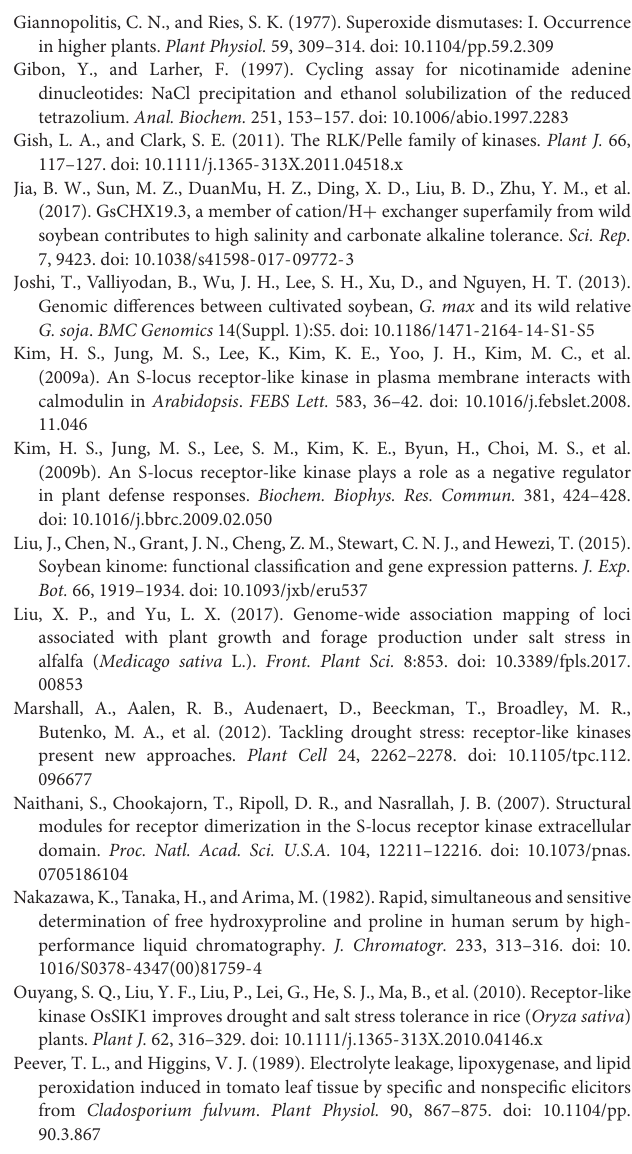
FIGURE S1 | Salt stress tests of GsSRK-f and GsSRK-t transgenic alfalfa in greenhouse. (A) The vertical view to show the growth performance of WT, GsSRK-f and GsSRK-t transgenic alfalfa under salt stress. (B) The side view to show the plant height and branching of WT, GsSRK-f and GsSRK-t transgenic alfalfa under salt stress. (C) Detailed photos to show the growth performance of individual alfalfa plants under salt stress. The WT and transgenic alfalfa